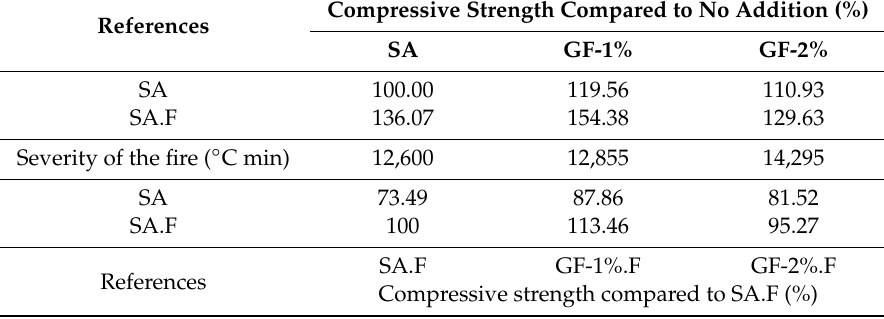
Table 5. Relationship between strengths, as a percentage, according to the type and percentage of addition and before and after fire testing and the severity of the